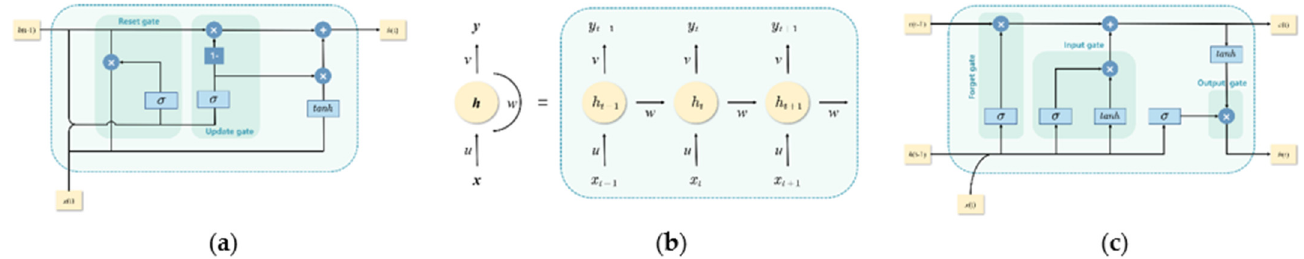
Figure 5. GRU, RNN, and LSTM neuron modules; ( a ) gated recurrent units (GRUs), ( b ) recurrent neural networks (RNN), ( c ) long short-term memory (LSTM); where h t − 1 and h t represent the outputs of the module at time t − 1 and t , respectively; x t and y t denote the input and output of the module at time t ; c t indicates the state information of the module at time t ; and σ and tanh are the sigmoid and hyperbolic tangent activation functions.